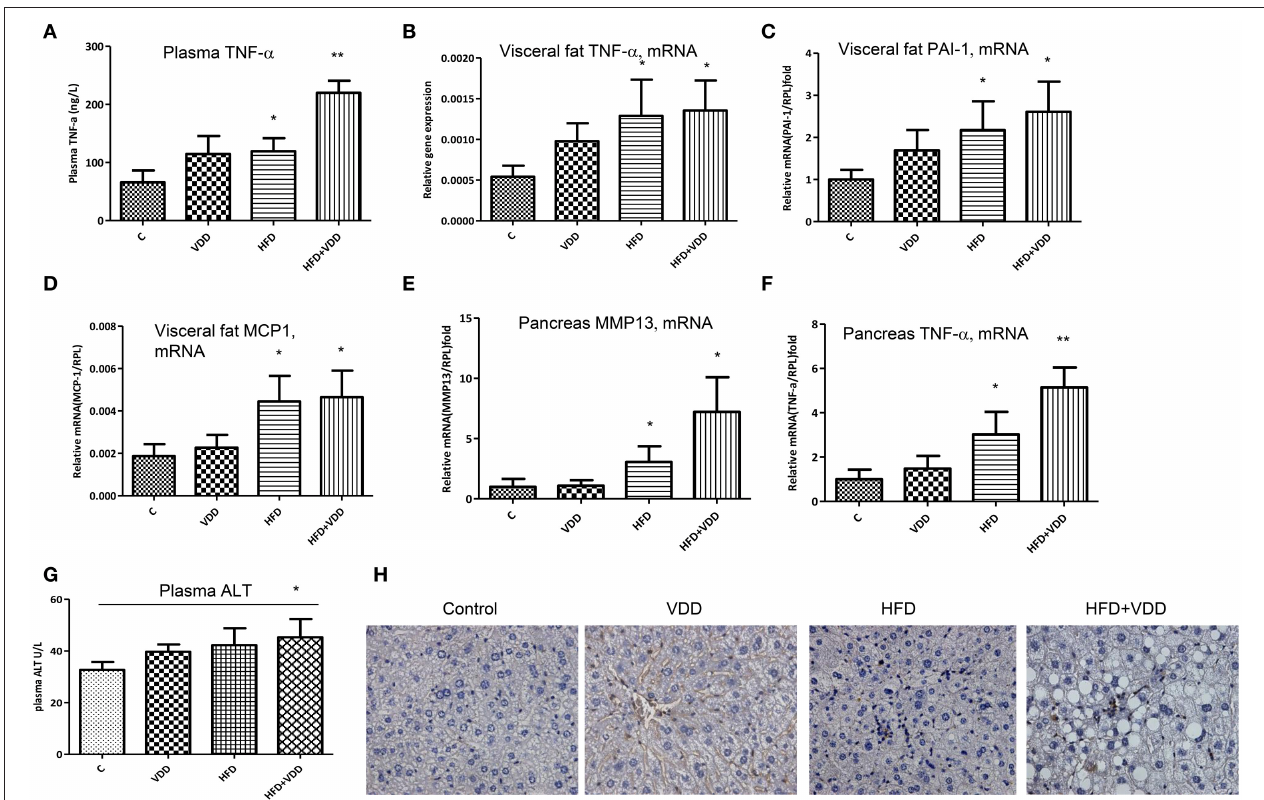
FIGURE 2 | Systemic and local inflammation is aggravated by dietary vitamin D deficiency. Balb/C mice were fed with four conditions for 18 weeks as described in Figure 1 . (A) Plasma TNF- α levels were measured by an ELISA kit. (B – D) In the visceral fat tissue, the mRNA levels of TNF- α , PAI-1, and MCP-1 were measured by RT-qPCR analysis. (E , F) In the pancreas, the mRNA levels of MMP13 and TNF- α were determined by RT-qPCR analysis. (G) Plasma, alanine aminotransferase (ALT) levels. (H) Lymphocyte infiltration in the liver was determined by CD3 staining. Data represent two independent experiments ( n = 6–10 mice/group for each measurement). Error bars represent the SEM of samples within a group. * p ≤ 0.05, ** p ≤ 0.01 in comparison with the control.